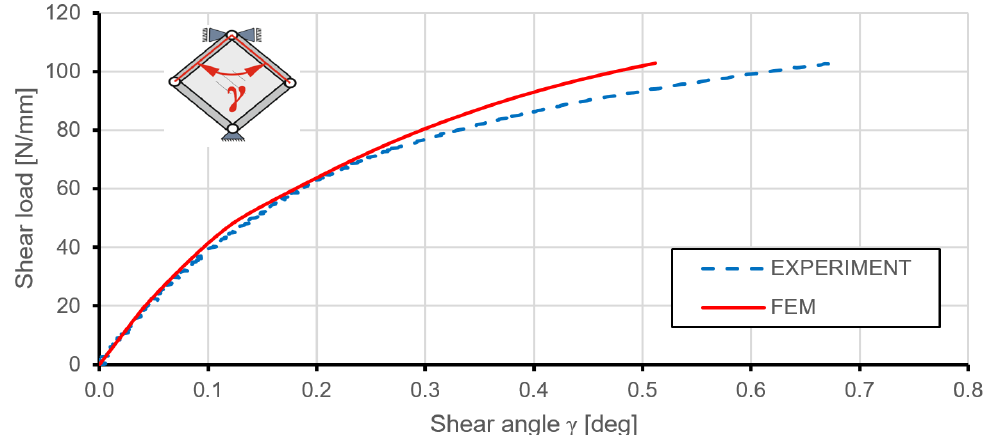
Figure 9. Shear load versus shear angle obtained for stiffened plates.